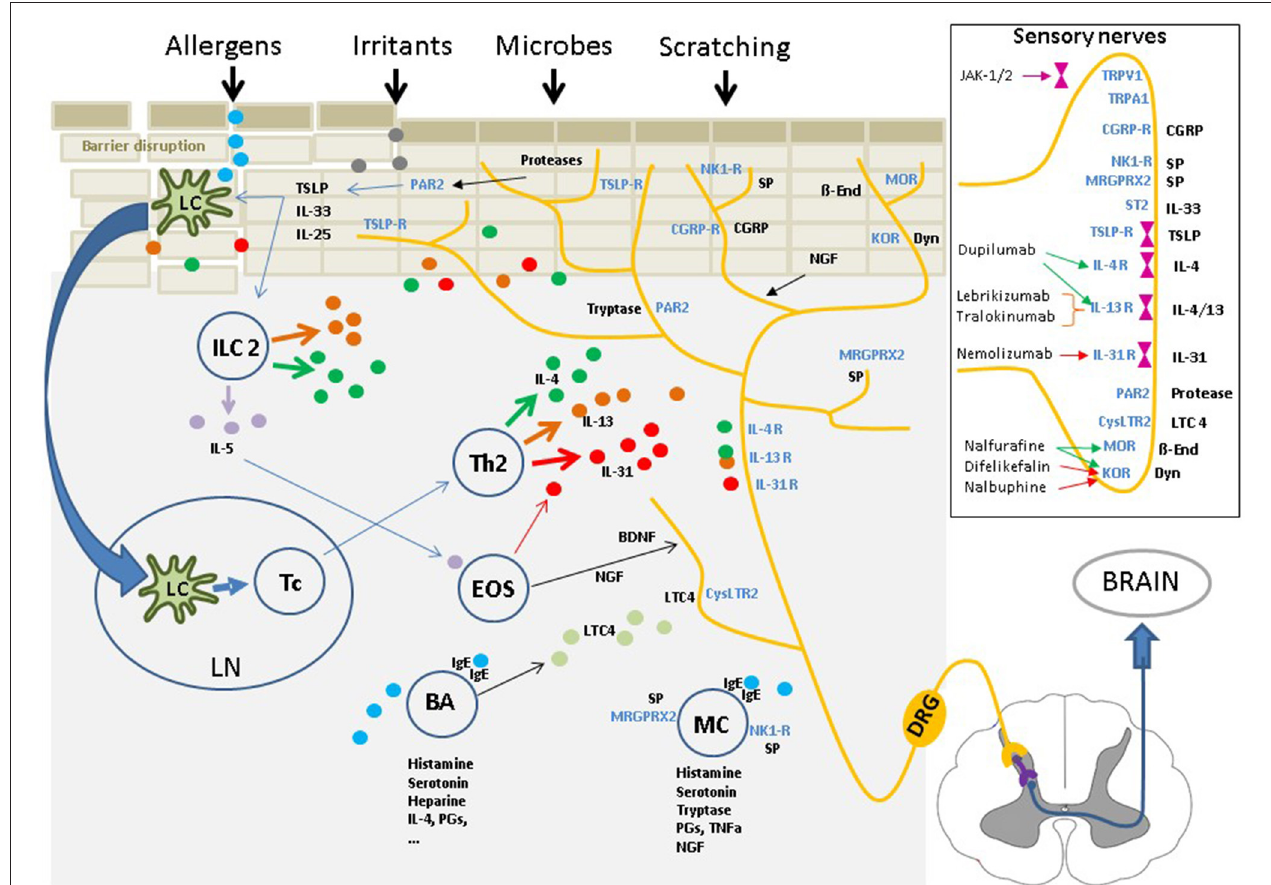
FIGURE 1 | The cutaneous neurosensory system occupies a central position within the “pathophysiological triangle” of epidermal barrier disruption, immune dysfunction, and environmental impacts due to external stimuli. The cutaneous sensory nerves are in close contact with resident and infiltrating cells and are affected by a myriad of mediators from these cells. Upon stimulation, the signal is mediated via pruriceptive nerve fibers and the dorsal root ganglia extending to the dorsal horn of the spinal cord. From there, the signal is transferred via interneurons to fibers of the lateral spinothalamic tract, which cross over to the contralateral side, extend up to the thalamus and, finally, reach multiple brain regions, where the nervous signal is perceived as an itching sensation, and scratching is induced. Insert: Multiple itch transmitting receptors are located on sensory nerve fibers, some of which are associated with intracellular Janus kinases. Targeting these receptors or the intracellular Janus kinases with specific inhibitors has shown to have significant antipruritic effects. IL, interleukin; TSLP, Thymic stromal lymphopoetin; NK1-R,neurokinin-1 receptor; CGRP/-R, Calcitonin gene-related peptide /-receptor; MRGPRX2, Mas-related G-protein coupled receptor X2; IgE, Immunoglobulin E; PAR2, Protease activated receptor 2; TRPV1/A1, Transient receptor potential vanilloid 1/ankyrin 1 channel; LTC4, leukotriene C4; CysLTC4, LTC4 receptor; MOR, mu-opioid receptor; KOR, kappa-opioid receptor; Dyn, Dynorphin; ß-End, ß-Endorphin; SP, substance P; ST2,